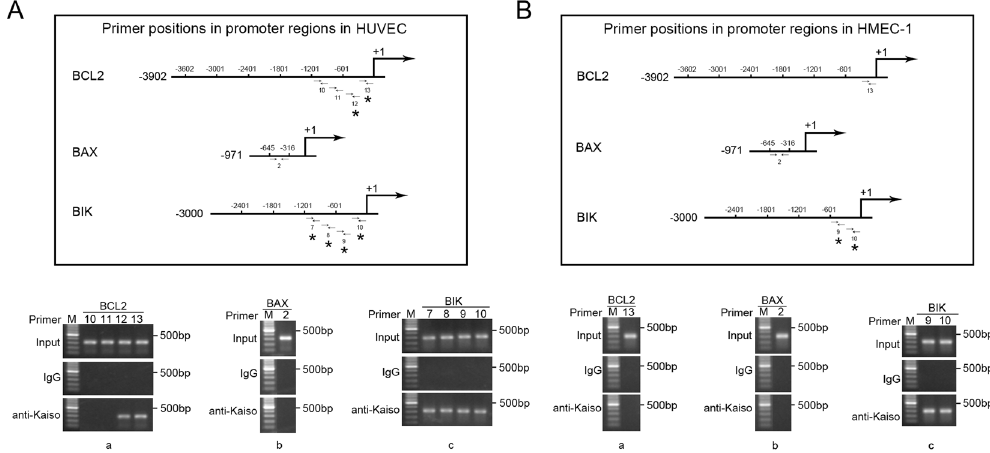
Figure 6. Kaiso binds to the promoters of BCL2 and BAX, at least partly, via methylated DNA. HUVECs ( A ) and HMEC-1s ( B ) were treated with 5 μ M 5-azacytidine for 72 h. DNA fragments (200–500 bp) were obtained from nuclear lysates and were subjected to chromatin immunoprecipitation. Mouse monoclonal anti-Kaiso 6F/6F8-CHIP grade antibody was used for Kaiso/DNA complex precipitation and the precipitated DNA fragments were amplified using primers 10–13 (BCL2) ( A ,a and B ,a), primer 2 (BAX) ( A ,b and B ,b) and primer 7–10 (BIK) ( A ,c and B ,c). Primer positions (horizontal arrows) are shown in the schematic drawings in the upper panel in A and B. Asterisks mark the positively amplified promoter regions. Normal mouse IgG was used as a negative control. M: DNA marker. ( A ) In HUVECs, after 5-azacytidine mediated DNA demethylation, Kaiso remained binding to the promoter regions − 601 to − 1 bp of BCL2 and − 1201 to − 1 bp of BIK (Asterisks) while no longer binding to the promoter region − 645 to − 316 bp of BAX. ( B ) In HMEC-1s, after 5-azacytidine mediated DNA demethylation, Kaiso remained binding to the promoter region − 601 to − 1 bp of BIK (Asterisks) while no longer binding to the promoter regions − 1201 to − 1 bp of BCL2 and − 645 to − 316 bp of BAX. DNA methylation/demethylation in BAX promoter region − 661 to − 301 bp was determined using methylation specific PCR (Supplementary Figure